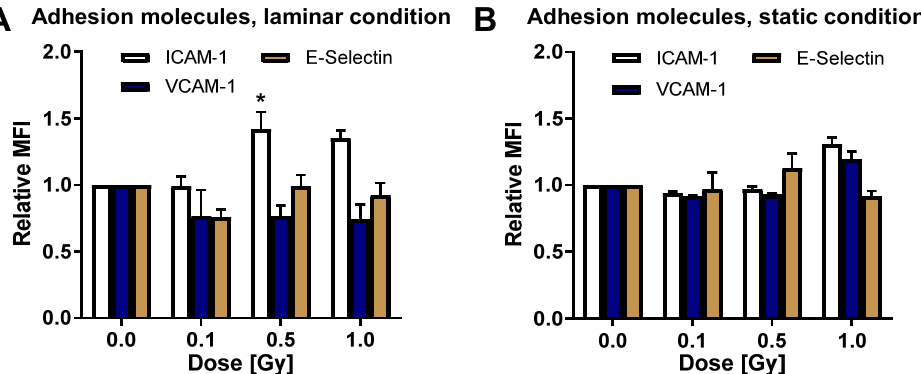
Figure 3. X-irradiation under laminar conditions reduces adhesion molecule surface expression. ( A ) For analysis of adhesion molecule protein expression under laminar conditions, HMVEC were exposed to laminar shear stress for 24 h, followed by irradiation and TNF- α stimulation. At 24 h after irradiation, cells were collected for flow cytometric analysis of ICAM-1, VCAM-1 and E-Selectin surface expression. Mean fluorescence intensities (MFI) + SEM are shown relative to non-irradiated cells. n = 4; * p < 0.05 (Mann-Whitney U test vs. +TNF- α ). ( B ) For analysis of adhesion molecule protein expression under static conditions, HMVEC were plated, medium was changed and irradiation and TNF- α was applied. Adhesion molecule protein expression on the cell surface was measured by flow cytometry, 24 h after irradiation, and displayed as MFI relative to non-irradiated cells + SEM ( n = 4). To exclude that regulation of stress factors endothelial nitric oxide synthase (eNOS) or heat shock protein 70 (Hsp70) impacts the reduced adhesion upon 0.1 Gy, we measured eNOS mRNA and Hsp70 protein expression under the same conditions as described